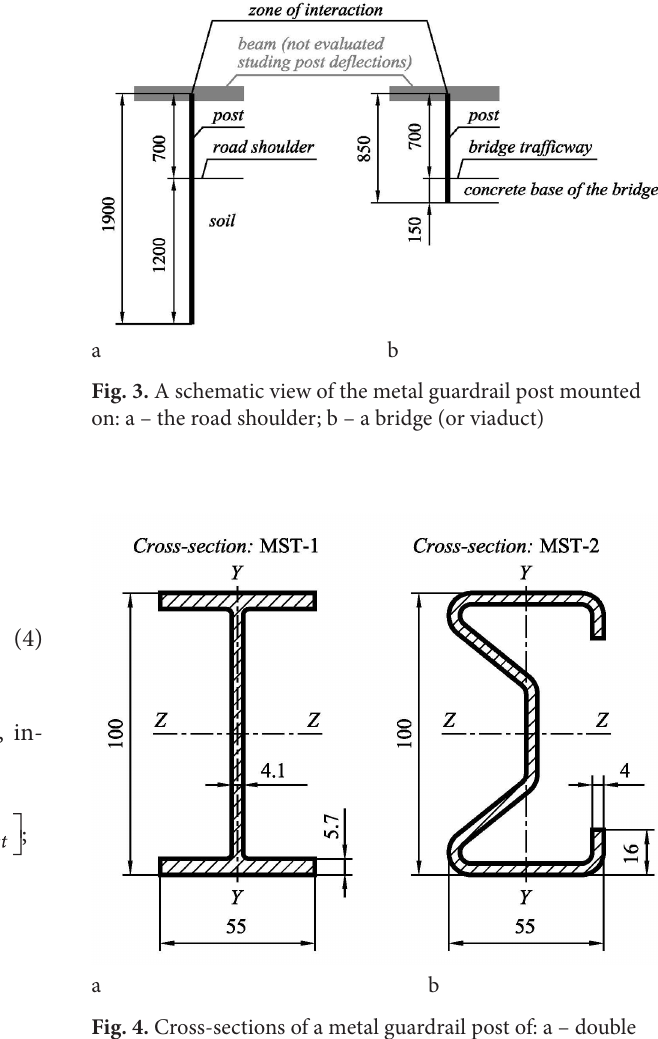
Fig. 4. Cross-sections of a metal guardrail post of: a – double T-shape; b –